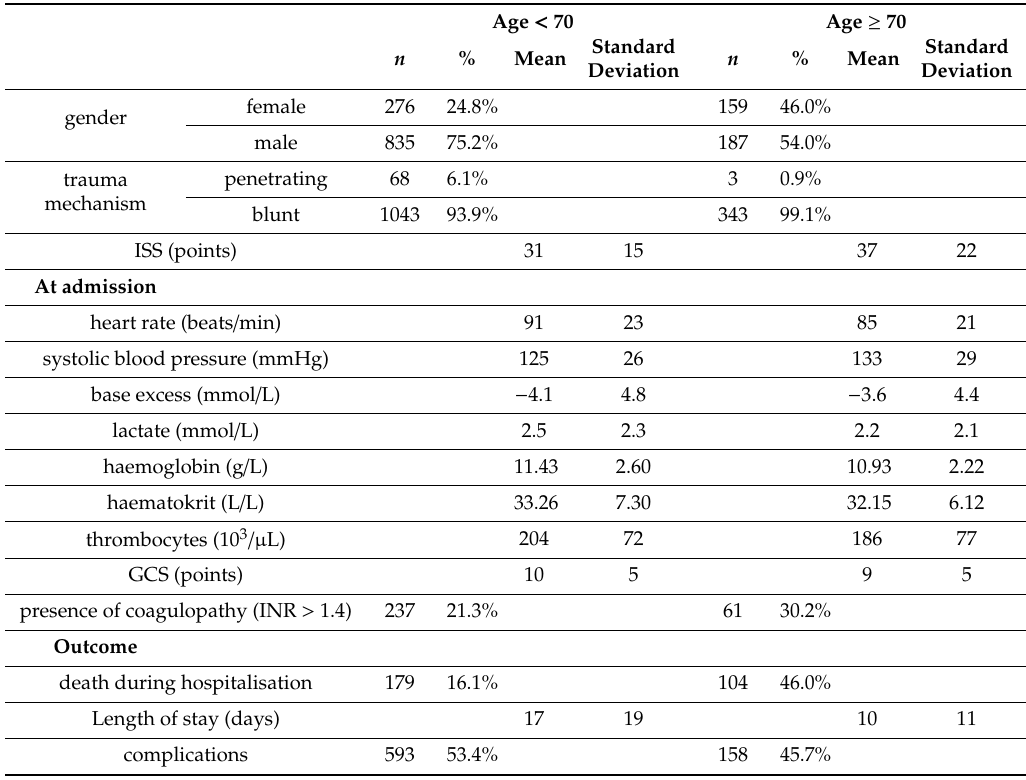
Table 1. Baseline characteristics and comparison between the age groups.